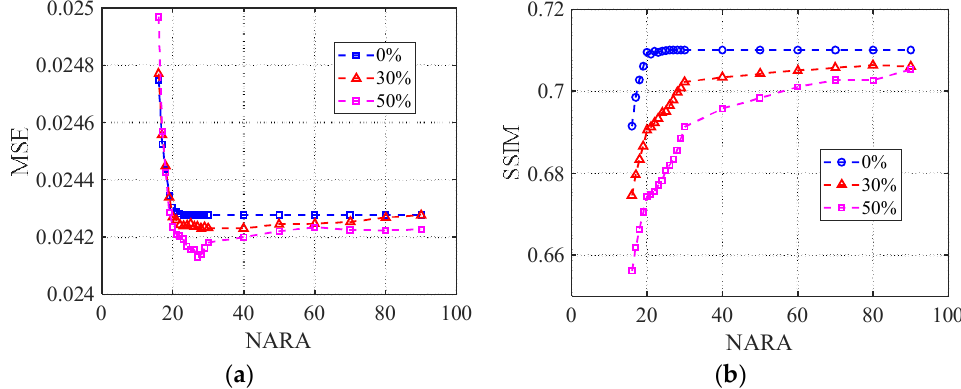
Figure 4. Effect of NARA on MSE and SSIM under different noise levels: ( a ) MSE; ( b ) SSIM.